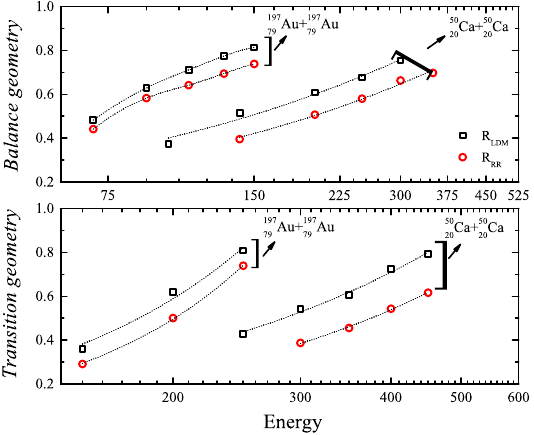
Figure 3. Incident energy dependence of "balance geometry" (ˆ b bal ) (upper panel) and "transition ge- ometry" (ˆ b trans ) (lower panel) for the reactions of 50